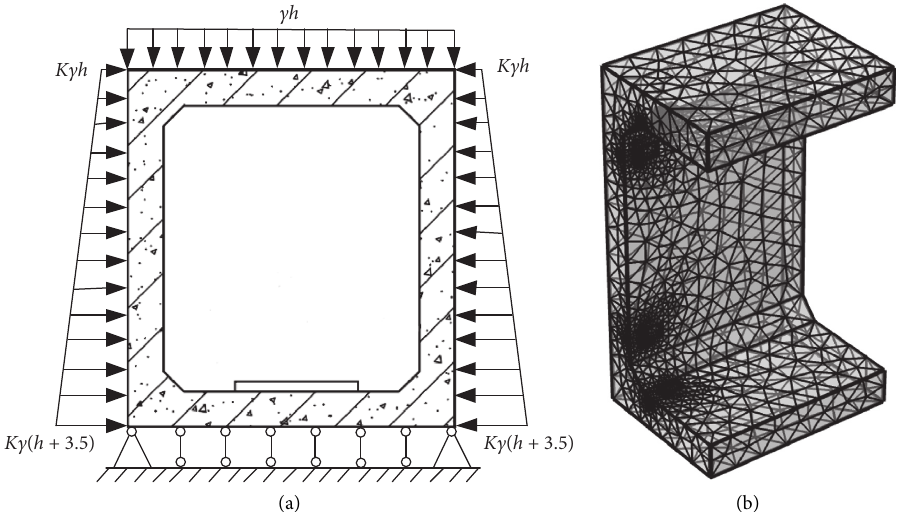
Figure 3: Numerical calculation model. (a) Load and constraint diagram. (b) Model meshing